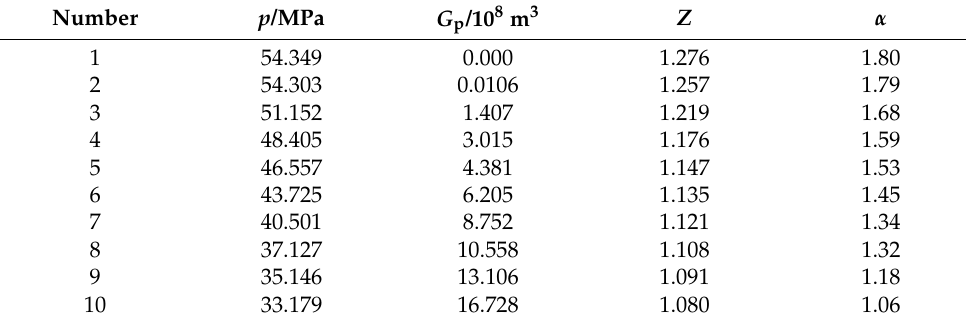
Table 5. Historical production data of well